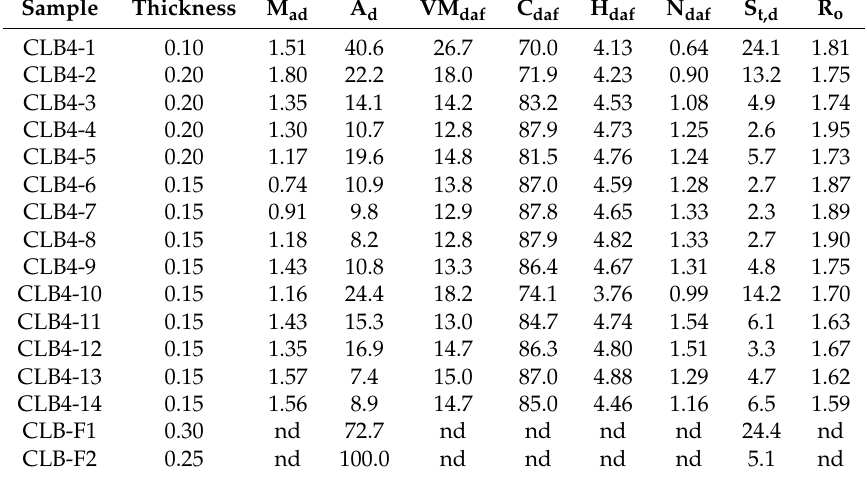
Table 1. Thickness (m), proximate and ultimate analyses (wt. %), and vitrinite random reflectance (%) of the coal and floor samples from the Chalinbao underground coal mine in the Tongzi Coalfield. Sample